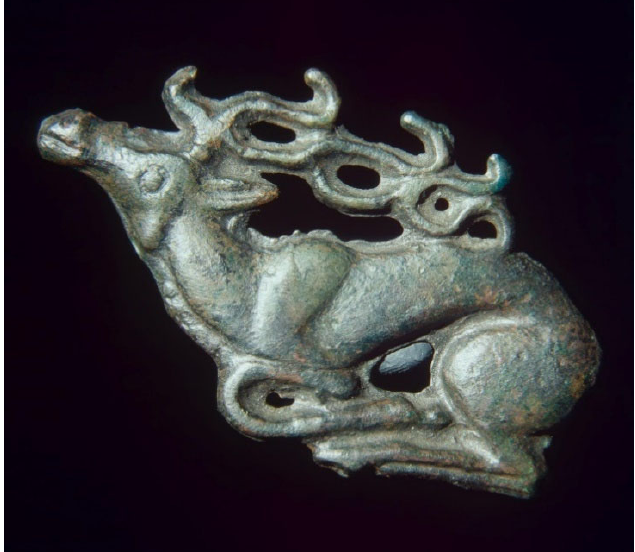
Figure 4. Plaque in the form of a stag (SHM inv. no. 1293-198); cast bronze; Maly Telek, Khakass- Minusinsk Basin, Krasnoyarsk Territory, Southern Siberia, Russia; Tagar culture, 7th to 6th century